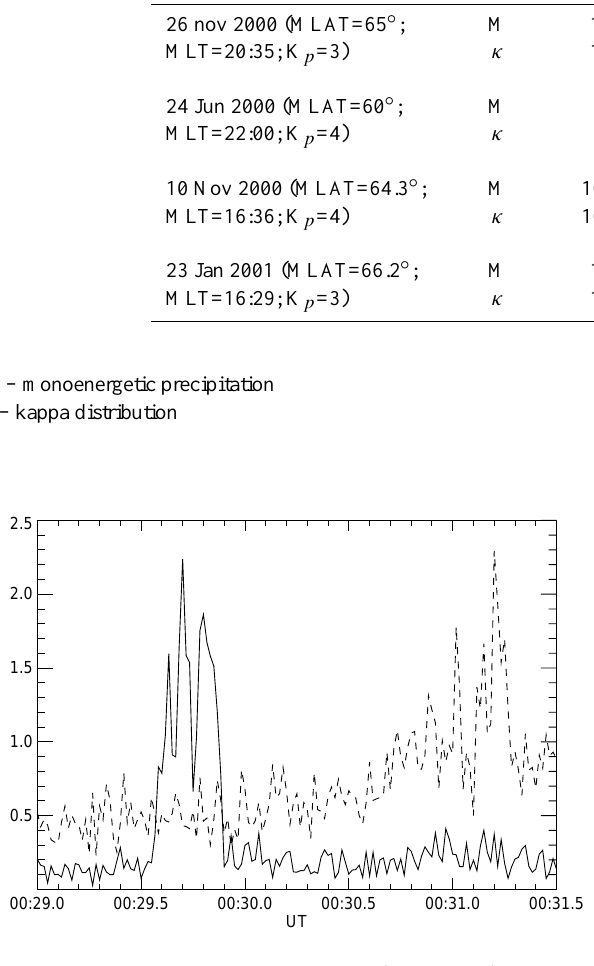
Fig. 8. Energy fluxes of auroral electrons (dashed line) and pro- tons (solid line) along the DMSP F13 satellite orbit while crossing a detached subauroral arc and the main oval on 10 November